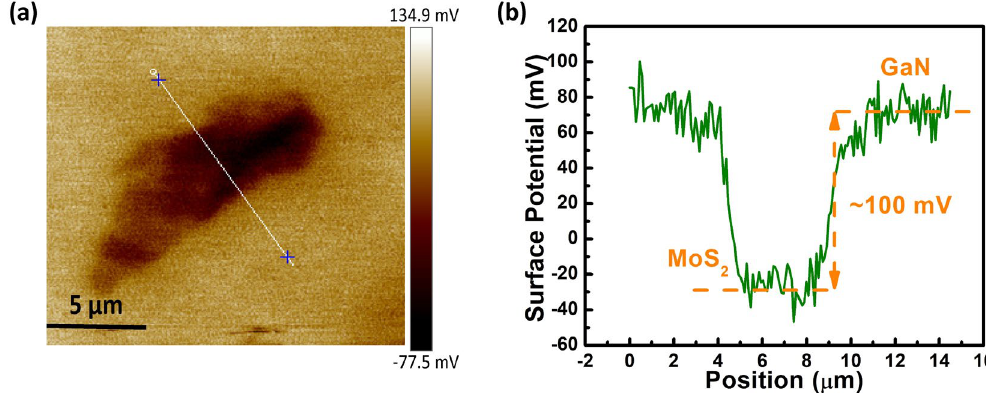
Figure 4. ( a ) Kelvin Probe Force Microscope (KPFM) image of MoS 2 flake on n-GaN showing change in surface potential between MoS 2 and GaN. ( b ) Plot of surface potential difference with lateral distance across MoS 2 /GaN interface along the line as indicated in ( a